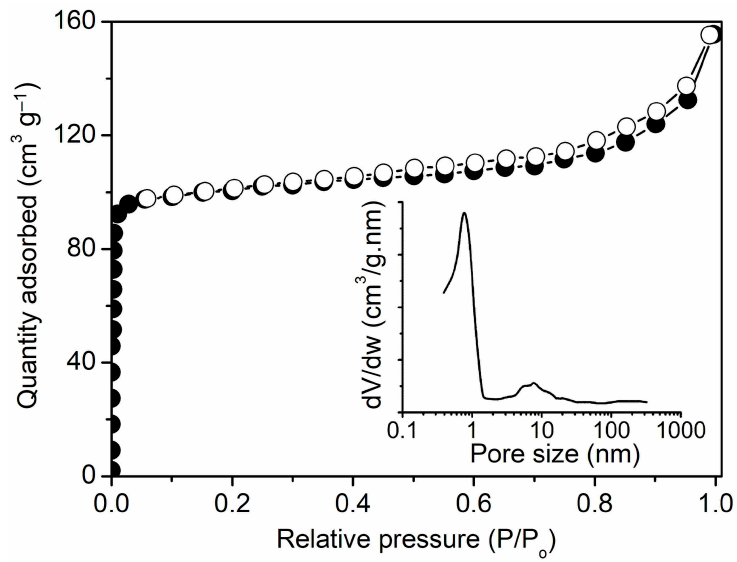
Figure 8. Nitrogen adsorption (close symbols) and desorption (open symbols) isotherms and (inset) pore size distribution of calcined SAPO-11 (E-3) sample at − 196 ◦ C. FTIR spectroscopy investigation of pyridine adsorption is one of the most popular methods for characterizing the surface acidity. The study of the framework acidity (type, amount and strength) is based on the bonding strength of the N nucleophile group of pyridine to the acid sites of SAPO-11 (Si species) [52]. The FTIR spectra of pyridine adsorbed SAPO-11 after desorption at 150 and 300 ◦ C are shown (Figure 9). In general, the SAPO-11 contains both Lewis and Brønsted acidities, based on the IR bands at 1455 and 1545 cm − 1 , respectively. The Lewis acid sites (158 µ mol g − 1 ), which come from structural defects after calcination, are higher than the Brønsted acid sites (136 µ mol g − 1 ) (Table 2, Figure 9) [53]. The quantity of acidity of SAPO-11 at 300 ◦ C is also determined where it can distinguish the strength of acid sites. It can be seen that some IR bands are still retained, indicating the presence of medium-to-strong Lewis (40 µ mol g − 1 ) and Brønsted (61 µ mol g − 1 ) acid sites in the solid. Hence, the results show that the synthesized SAPO-11 is a mild-to-strong acid solid catalyst with a total acidity slightly higher than that of the conventional SAPO-11 [54].